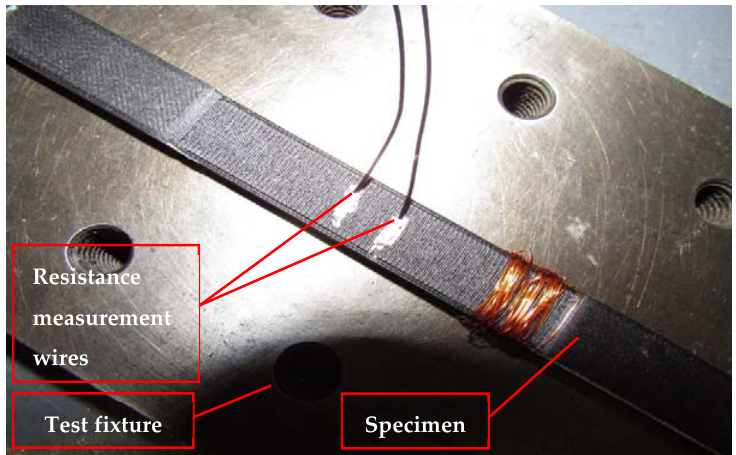
Figure 1. Test specimen with instrumentation for measurement of the electrical resistance of the test specimens.